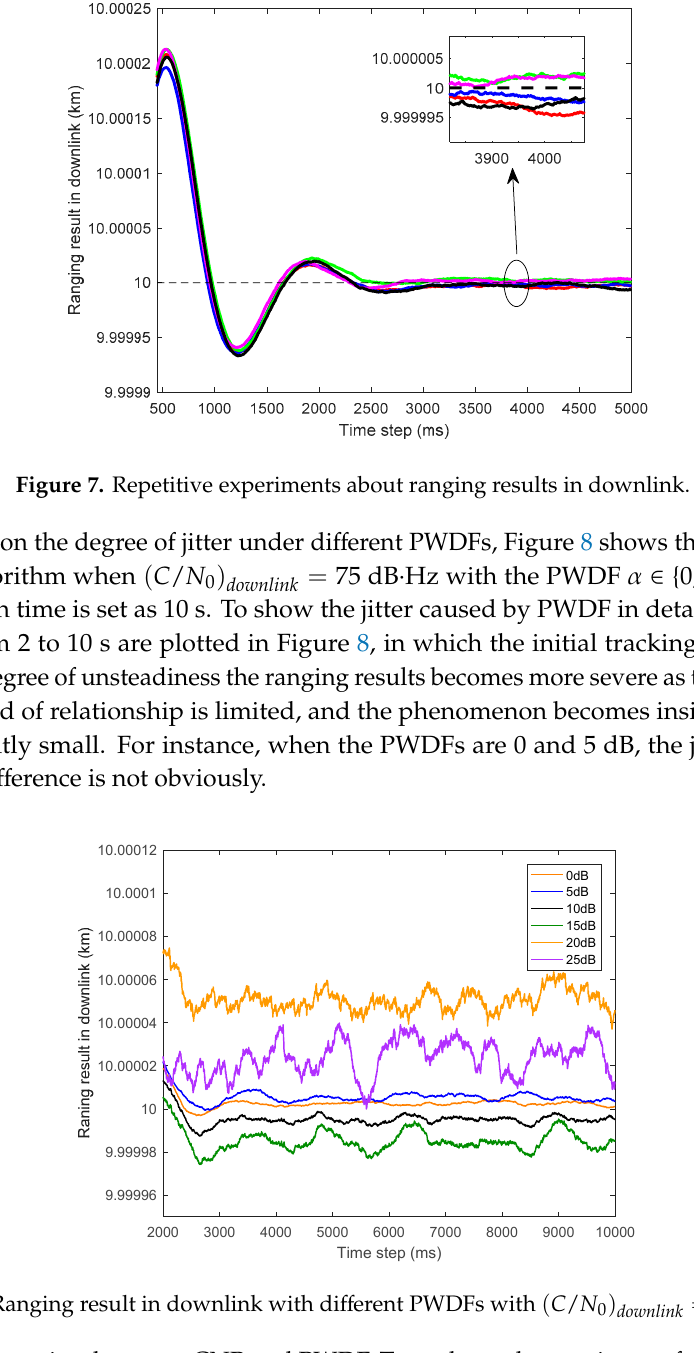
Figure 8. Ranging result in downlink with different PWDFs with (𝐶/𝑁 (cid:2868) ) (cid:3031)(cid:3042)(cid:3050)(cid:3041)(cid:3039)(cid:3036)(cid:3041)(cid:3038) = 75 dB·Hz